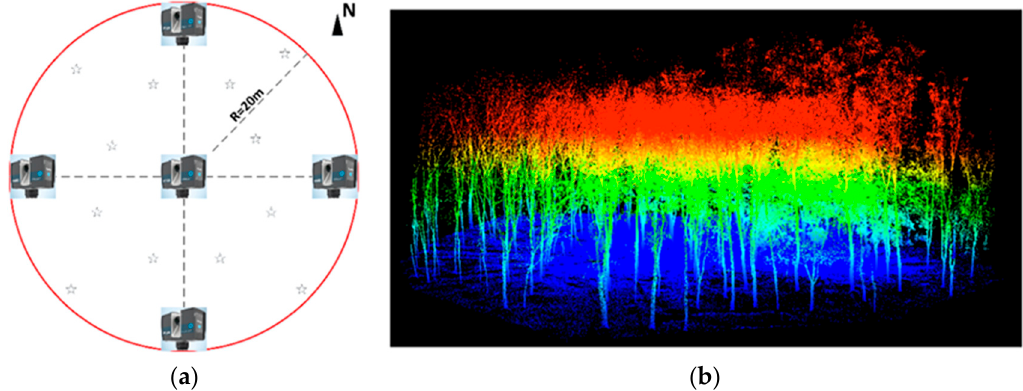
Figure 1. Geometry of the reference plot and the point clouds of Chinese scholartree derived by terrestrial laser scanning (TLS). ( a ) Circular reference plots for multi-scan mode TLS field work and the reference targets spheres were illustrated using stars; ( b ) semi-automatic segmentation of TLS point clouds at the classification points of ground (dark blue) and vegetation (RGB color according to height).